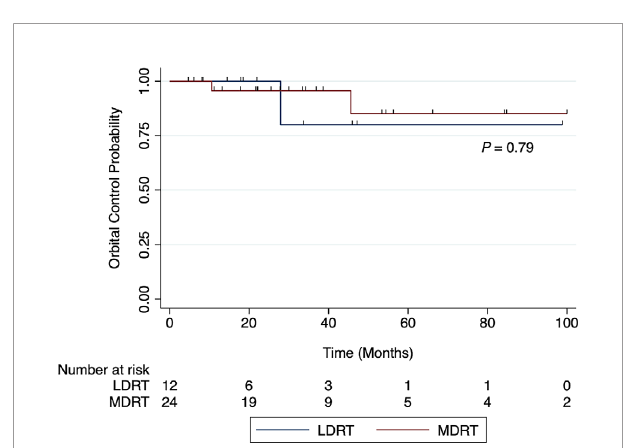
FIGURE 3 | Orbital control rates for patients with indolent orbital adnexal lymphomas treated with low-dose radiotherapy (LDRT) compared to patients treated with moderate-dose radiotherapy